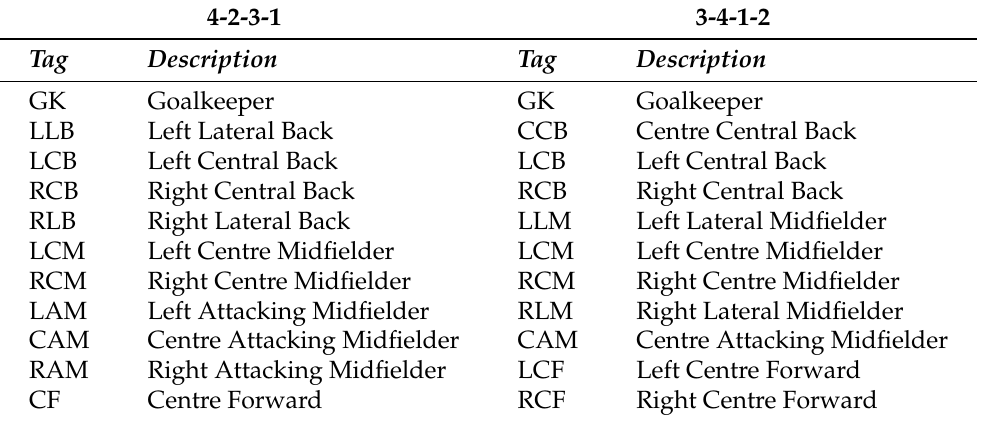
Table 1. Player’s role in 4-2-3-1 and 3-4-1-2 team